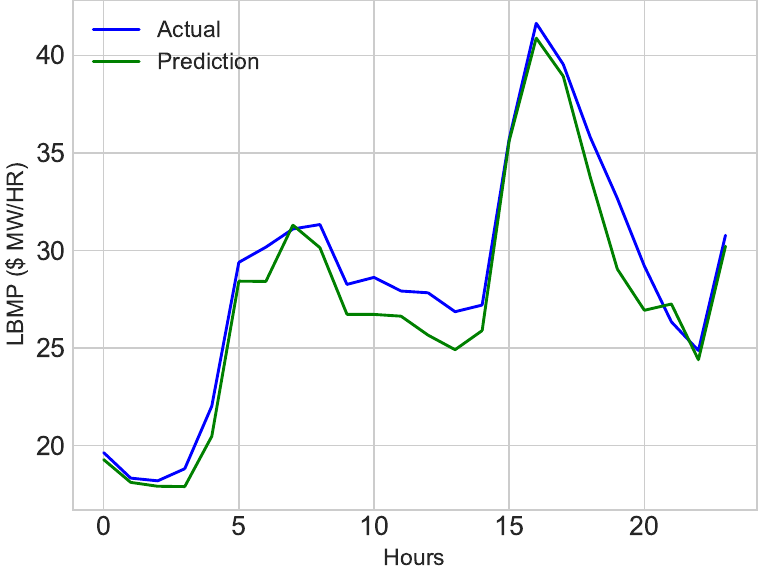
Figure 18. First Day of January,